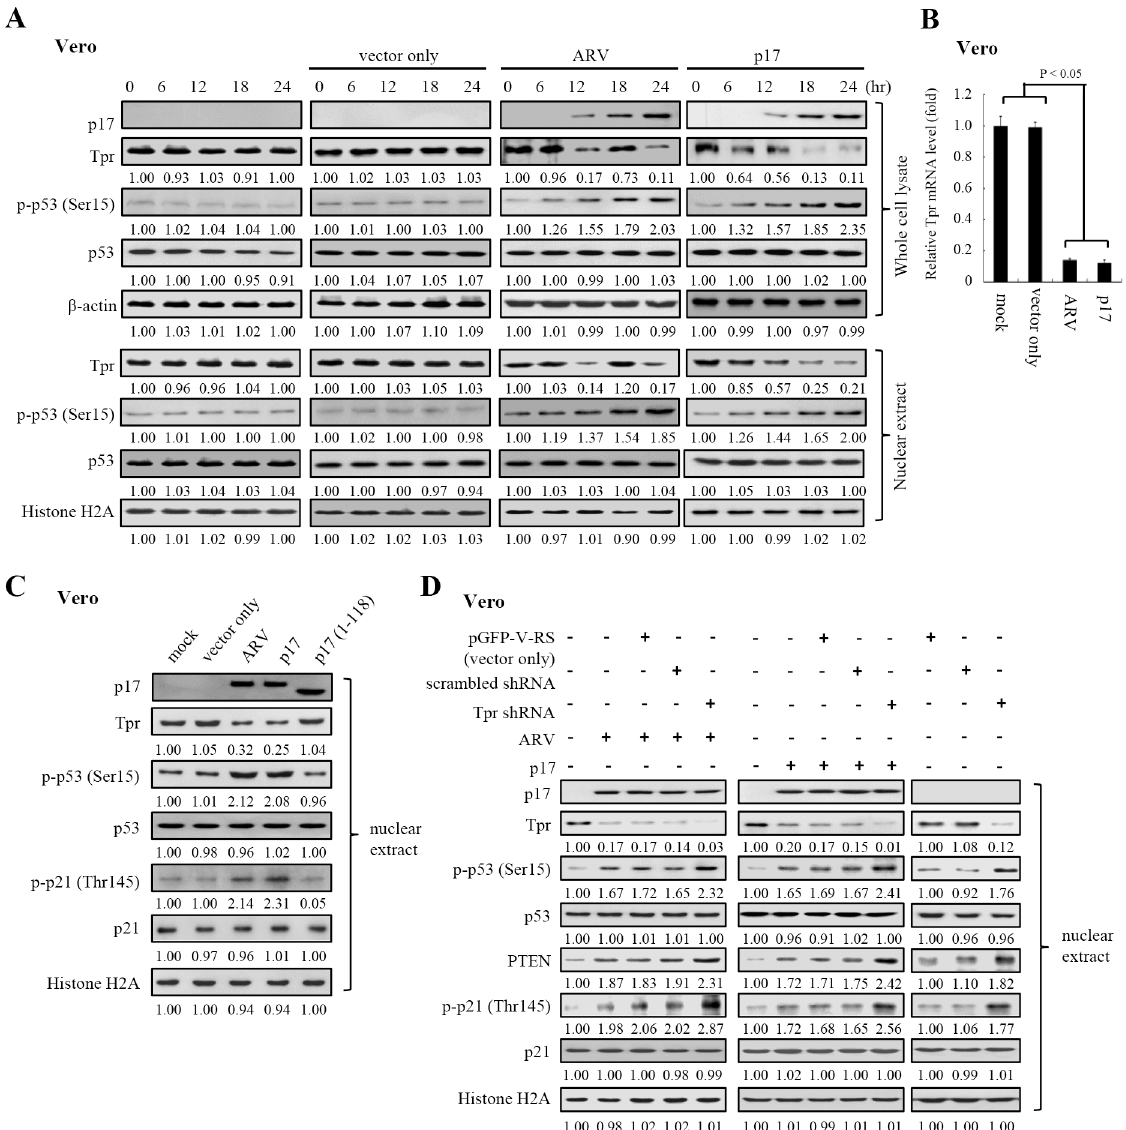
Fig 3. p17 functions as a Tpr suppressor leading to p53 and p21 nuclear accumulation. (A) Both Tpr and p53 levels in mock control (Vero cell only), pcDNA3.1 (mock transfection)-, pcDNA3.1-p17-transfected, and ARV-infected cells were examined. Whole cell lysates and nuclear extracts were collected at the indicated time points for Western blot assays. (B) To examine whether the Tpr transcription was down-regulated by p17, the Tpr mRNA levels in ARV- infected and pcDNA3.1-p17-transfected Vero cells were compared with those in mock treated cells. In semi-quantitative RT-PCR amplification of the p17 and Tpr genes, Vero cells were transfected with pcDNA3.1-p17 or infected with ARV at an MOI of 10. The pcCNA3.1-p17 transfected or ARV-infected cells were collected at 24 hours postinfection (hpi), and total RNAs were extracted for semi-quantitative RT-PCR. After electrophoretic separation in an agarose gel, PCR products were stained with ethidium bromide. Mock transfection (vector only) and mock infection (cell alone) were included as negative controls. Graph shown represents the mean ± SD calculated from three independent experiments. (C) To study whether the p17 mutant (1 – 118), which does not possess a NLS, can influence the levels of p-p53 and p-p21 in the nucleus, vero cells were transfected with the p17 mutant (1 – 118) plasmid (negative control) for 24 hours. (D) To study whether Tpr depletion affects p53, p21, and PTEN nuclear accumulation, nuclear extracts from ARV-infected and pcDNA3.1-p17-transfected Vero cells were collected for Western blot assays. Vero cells were transfected with Tpr shRNA for 6 hours before being infected with ARV at an MOI of 10 for 18 hours. In a parallel experiment, Vero cells were co-transfected with pcDNA3.1-p17 and Tpr shRNA plasmid for 18 hours. Nuclear extracts were collected for Western blot assays using the indicated antibodies. Either actin or histone H2A was used as loading controls. The activation and inactivation folds indicated below each lane were normalized against those at 0 h (panel A) or in mock controls (cell alone) (panels C and D). The levels of indicated proteins at 0 h or in the mock controls (cell alone) were considered